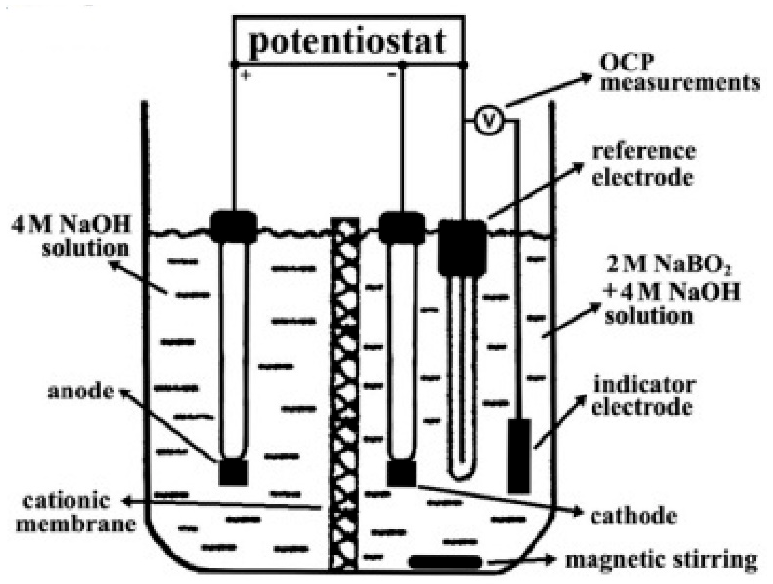
Figure 4. Electrochemical cell for bulk electrolysis of NaBO 2 and open circuit potential (OCP) measurements in alkaline solution at 25 °C. The NaBO 2 is reduced at the cadmium cathode while a high impedance voltmeter prevents current to flow into the circuit between the indicator and reference electrodes for the OCP monitoring. Reproduced from ref. [22] with permission from the